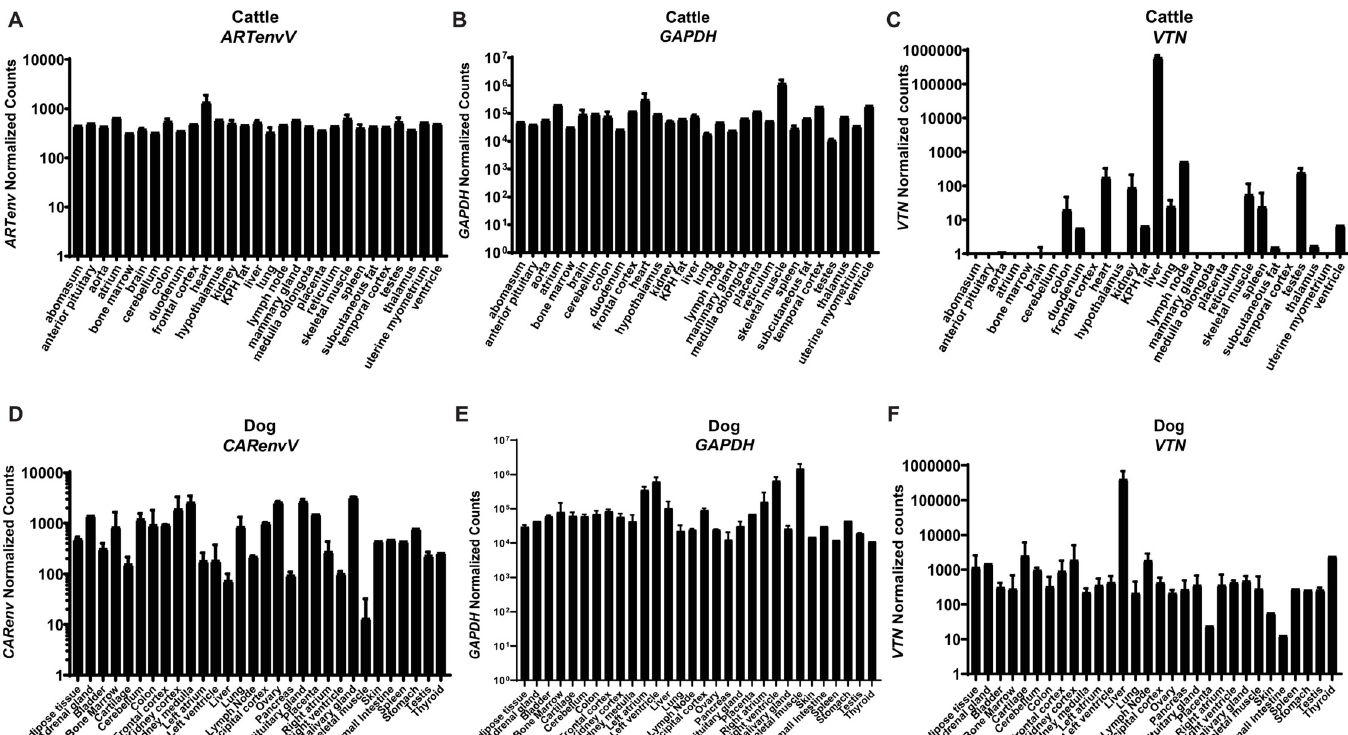
Fig 9. CARenvV and ARTenvV are expressed in a wide variety of tissues. In silico analyses of RNA sequencing data from 29 tissues from cattle ( B . taurus ) and 30 tissues from domestic dog ( C . lupus familiaris ) are shown for A. cattle ARTenvV , B. cattle GAPDH , C. cattle VTN , D. dog CARenvV , E. dog GAPDH and F. dog VTN . The mapping accuracy of the RNA sequencing reads, and the normalization of the read counts was confirmed using as controls a liver specific gene (VTN) ( C. and F. ) or a housekeeping gene ( GAPDH ) ( B. and E. ). Raw RNA sequencing data extracted from SRA projects PRJNA314981, PRJNA78827, PRJNA379574, PRJNA177791 and PRJNA314981 were mapped to the cattle or dog genome assembly and the counts that map to the coding region of each gene were extracted and normalized using DEseq2. KPH: Kidney, pelvic and heart.